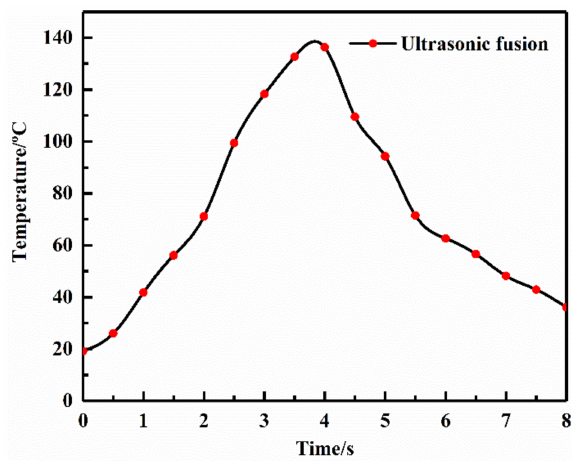
Figure 6. Interface temperature during ultrasonic